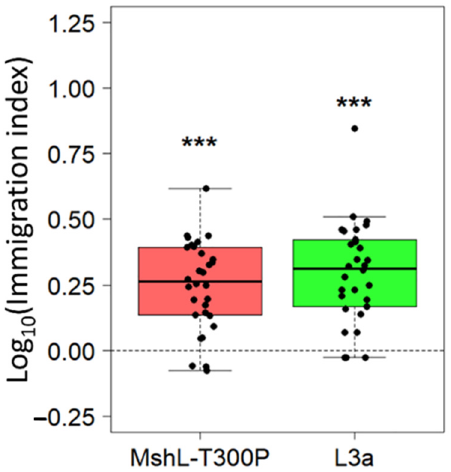
Figure 5. Relative per capita immigration of L3a and MshL-T300P mutants compared to wt MR-1. Each box shows the per capita immigration efficiency of the indicated strain relative to wt MR-1. Each point represents a single dissected and plated larval gut. Each group of points was t -tested against a mu value of zero, our expected value if there were no competitive advantage, and significance was determined after Bonferroni multiple-comparison correction ( p < 0.001: ***).